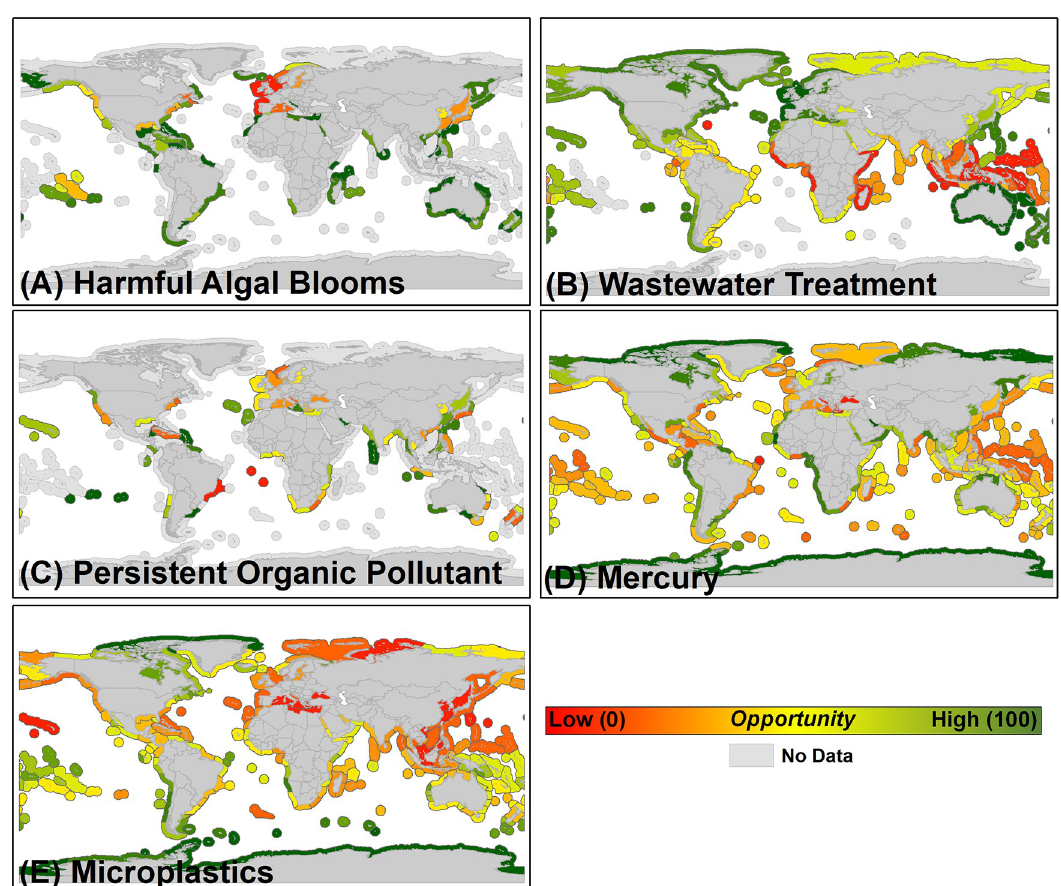
Fig 3. Human health factors integrated within the restorative aquaculture opportunity index used in determining high opportunity marine ecoregions for shellfish and seaweed restorative aquaculture development, including (A) harmful algal blooms, (B) wastewater treatment, (C) persistent organic pollutants, (D) mercury, and (E) microplastics. All factors are re- scaled to represent where shellfish and seaweed aquaculture development would be least likely to be impacted by these human health factors. For example, marine ecoregions with the lowest average mercury concentrations (D) are re-scaled to represent the highest opportunity ecoregions (dark green) where shellfish and seaweed aquaculture would be least likely to be impacted by elevated mercury